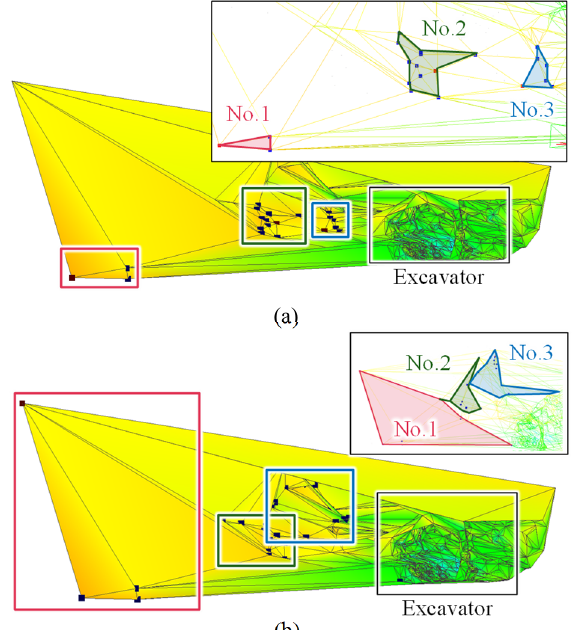
Figure 13. The selected low-quality regions; (a) using the 𝑘 -ring (condition 2a) and (b) using the average FOV height (condition 2b). A red dot indicates a shooting target point.